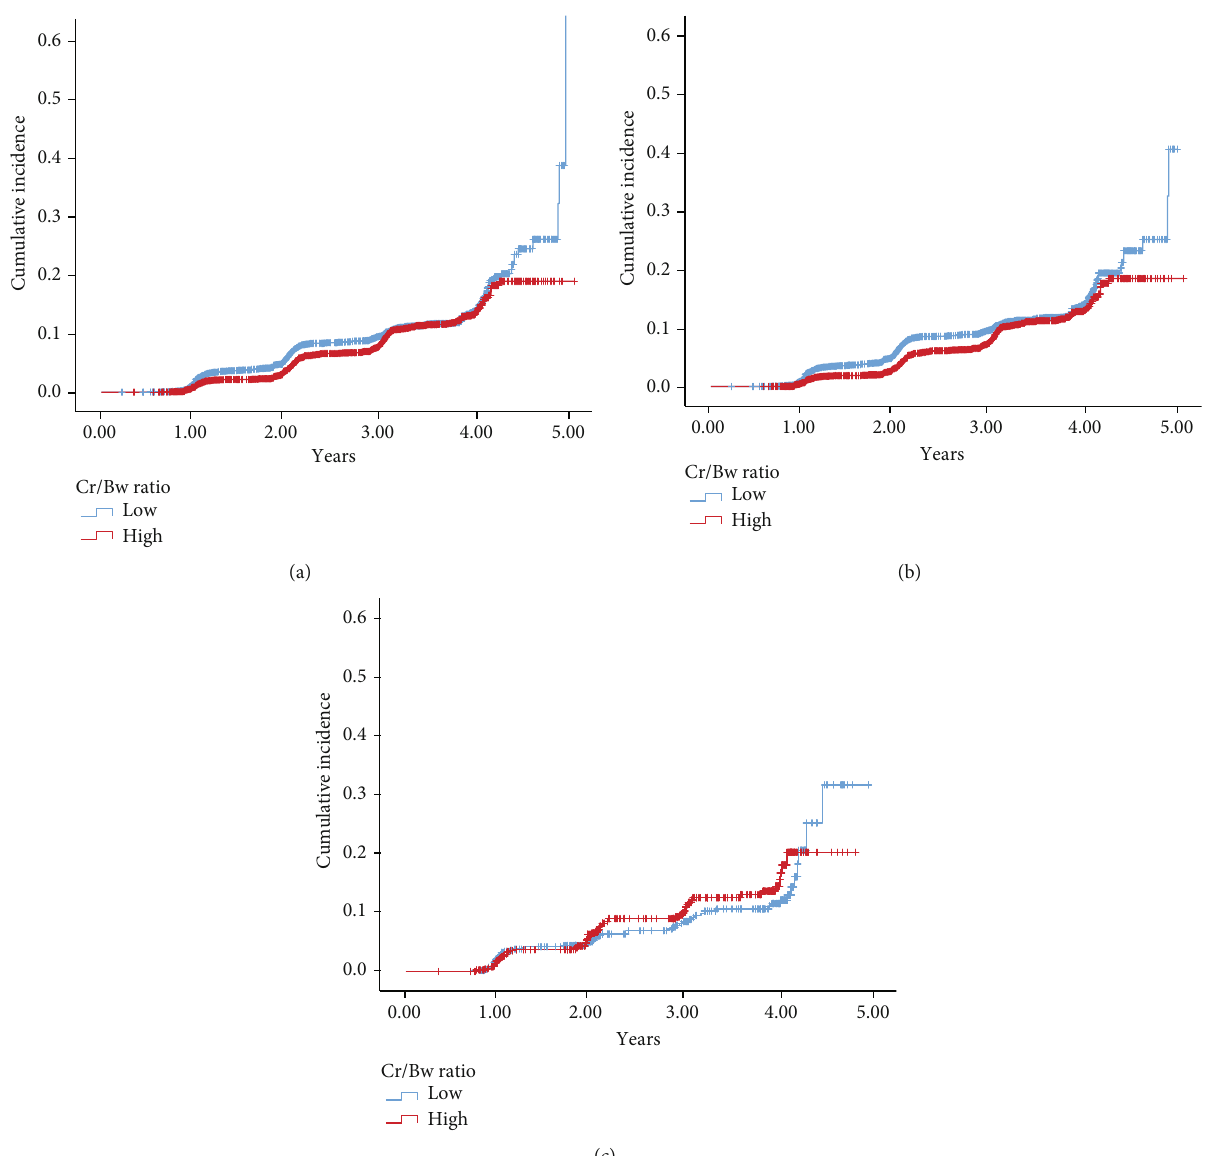
Figure 2: Cumulative incidence of nonalcoholic fatty liver disease for the whole population (a), nonelderly group (b), and elderly group